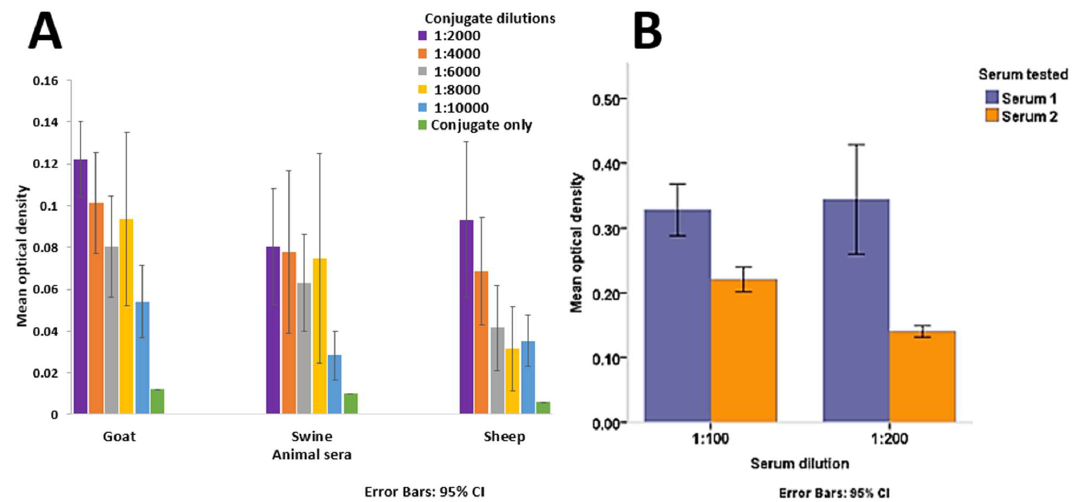
Figure 5. Mean optical densities of livestock sera at different conjugate dilutions (Panel ( A )). Mean optical density comparison for HCoV-NL63-positive (Serum 1) and negative (Serum 2) sera at two dilutions (Panel ( B )). Error bars depict 95% confidence intervals.